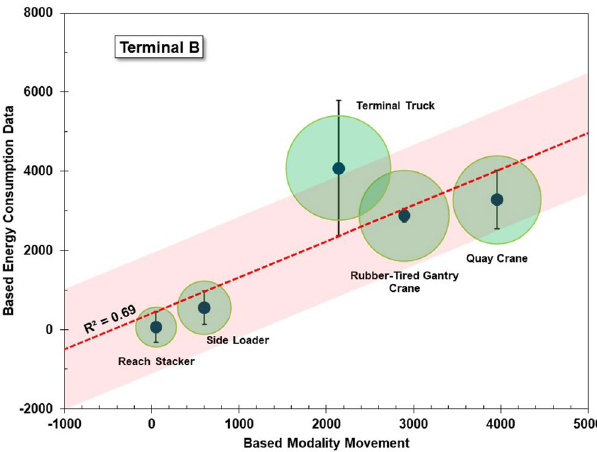
Figure 13. Robustness of the CO 2 emission calculation model for terminal